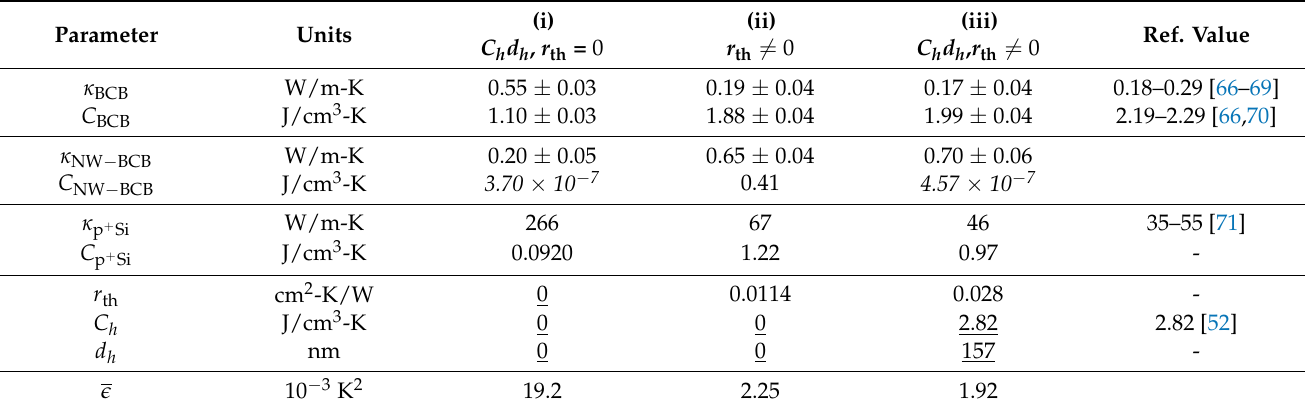
Table A1. Fitted parameter values for sample A.